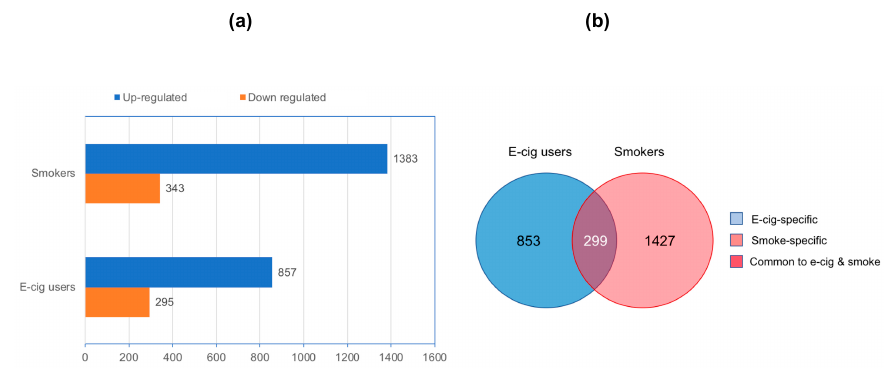
Figure 1. Aberrantly expressed transcripts detected by RNA-sequencing (RNA-seq) in electronic cigarette (e-cig) users and smokers as compared to controls. ( a ) Numbers of up-regulated and down-regulated transcripts in e-cig users and smokers are indicated. Fold-change: >1.5; P < 0.005. ( b ) Venn diagram of deregulated transcripts in e-cig users and smokers is shown.